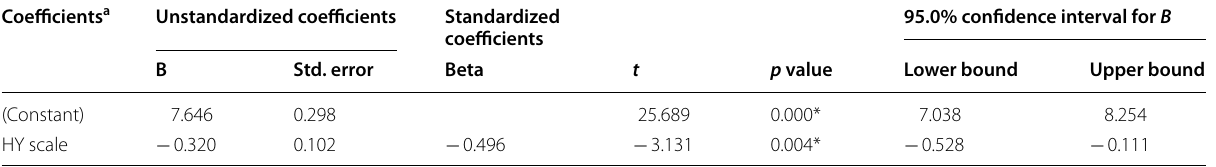
Table 5 Linear regression model of the macular volume